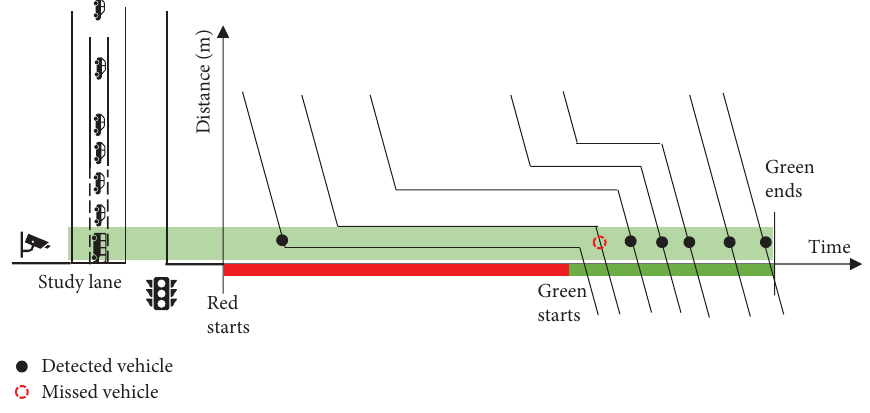
Figure 1: Detection process of LPR